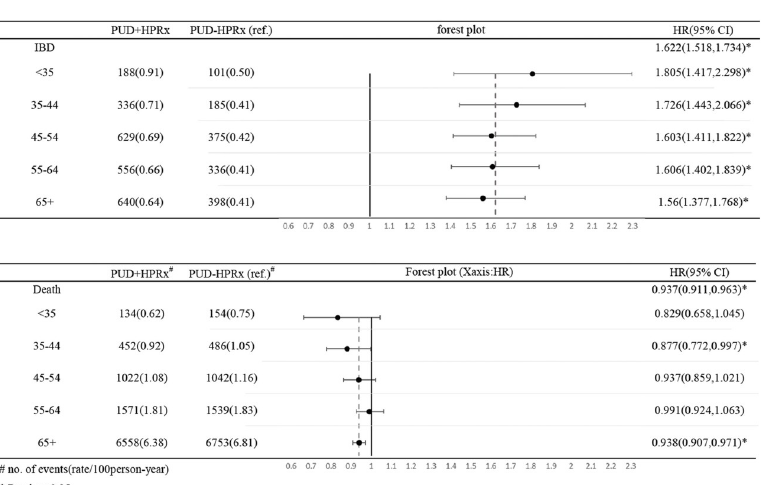
Fig 4. Forest plots of the PUD+HPRx and PUD-HPRx in DM groups. A higher hazard ratio of the incidence rate of IBD was noted in the younger patients in the PUD+HPRx in DM group, while a lower hazard ratio of the mortality rate was noted in the younger patients in the PUD+HPRx in DM